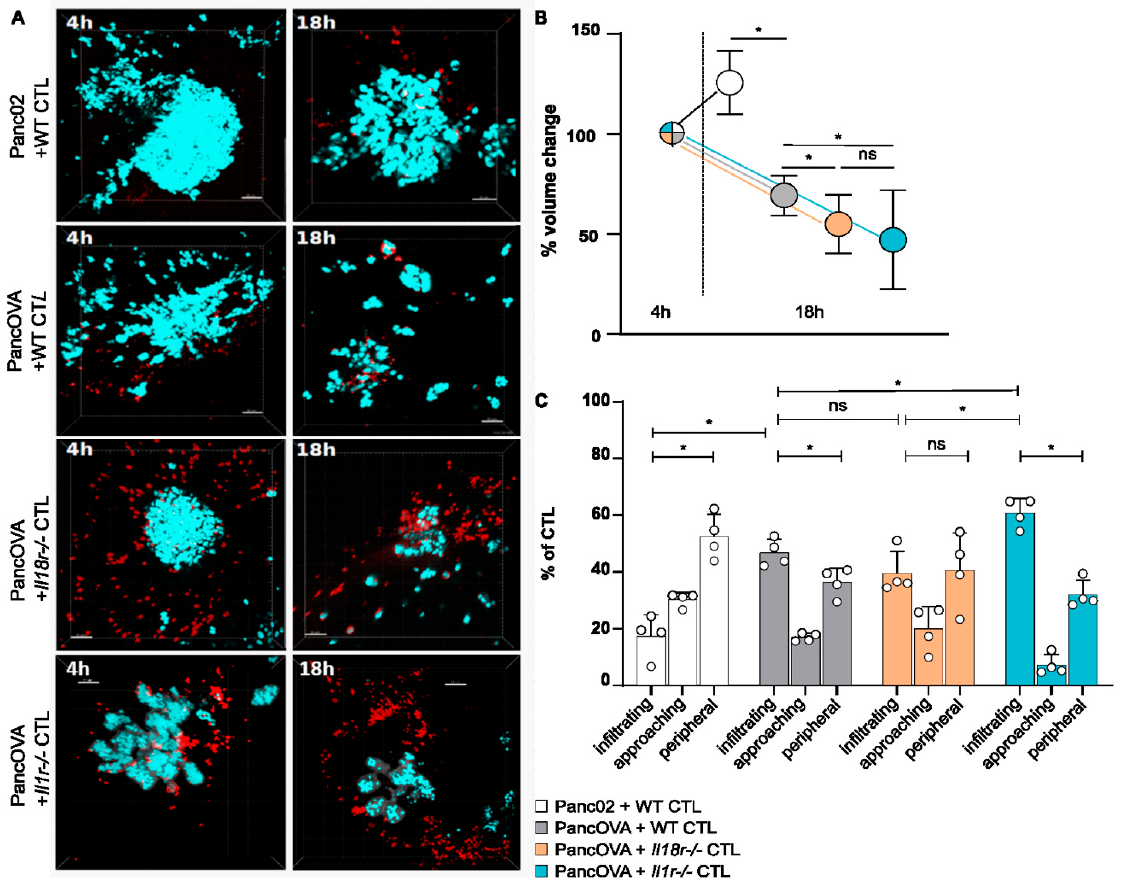
Figure 2. T-cellular IL-1R and IL-18R signaling inhibits the rejection of pancreatic cancer spheroids . ( A ) Representative three-dimensional reconstructions of H2b Cerulean Panc02 or H2b Cerulean PancOVA tumor spheroids in coculture with OT-1 CTLs after 4 and 18 h. Tumor cell spheroids were generated by using Corning Matrigel. CTLs were derived from WT, Il1r − / − , or Il18r − / − OT-1 mice that expressed a transgenic T-cell receptor recognizing OVA-derived peptide SIINFEKL. Tumor cells are depicted in turquoise, CTLs in red; scale bar = 50 μ m. ( B ) Imaris software was used to calculate the spheroid volume of 5 randomly chosen spheroids from MPM-derived z-stacks. Initial tumor volume after 4 h of coculture was normalized to 100%. The relative growth/regression of spheroids cocultured for 18 h with WT, Il1r − / − , and Il18r − / − CTLs was calculated. Graph represents the results of n = 6–13 independent experiments per subgroup. ns = not significant. ( C ) The antigen-specific infiltration of OT-1 CTLs into PancOVA spheroids via intravital MPM. The number of CTLs was detected through analysis via Imaris software with a spot algorithm after separation into different regions: inside the spheroid (infiltrating), <10 µ m to surface of the spheroid (approaching), and >10 µ m to the surface of the spheroid (peripheral). Results are expressed as the mean ± standard deviation (SD) for n = 4 independent experiments per group. An unpaired, two-tailed t -test was performed; * p < 0.05. ns = not